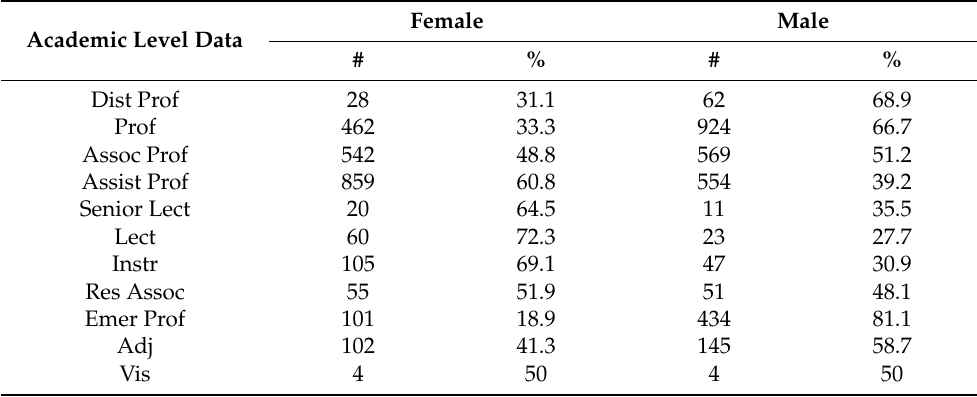
Table 5. Gender distribution across different academic levels in the